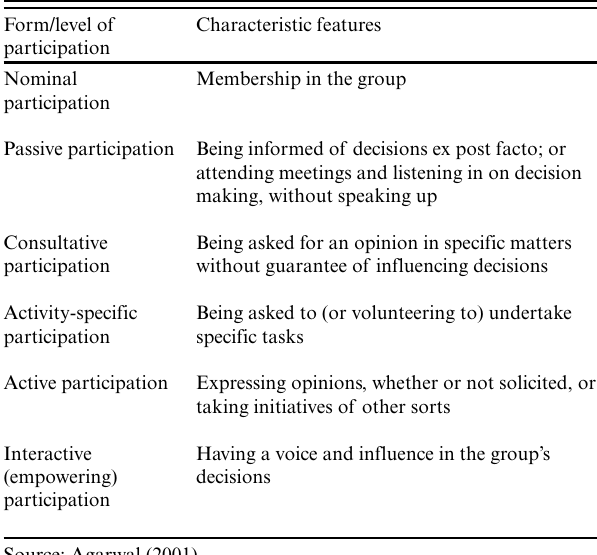
Table 1 . Typology of